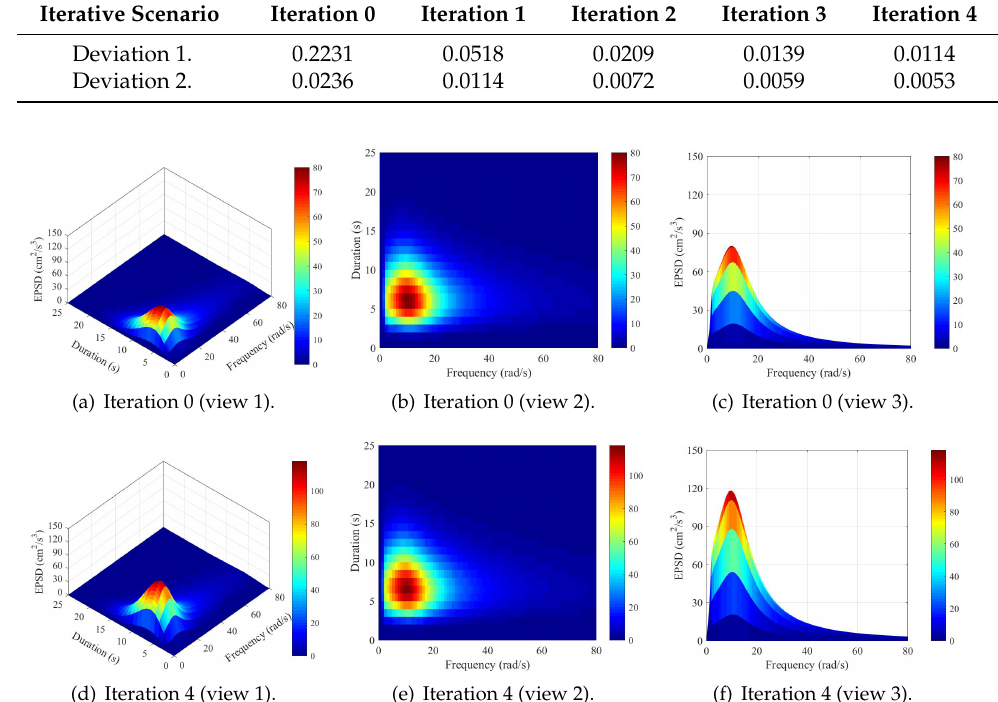
Figure 5. The relationship between the evolutional PSD, the earthquake frequency and the earthquake duration in the iterative PSD-based stochastic model.